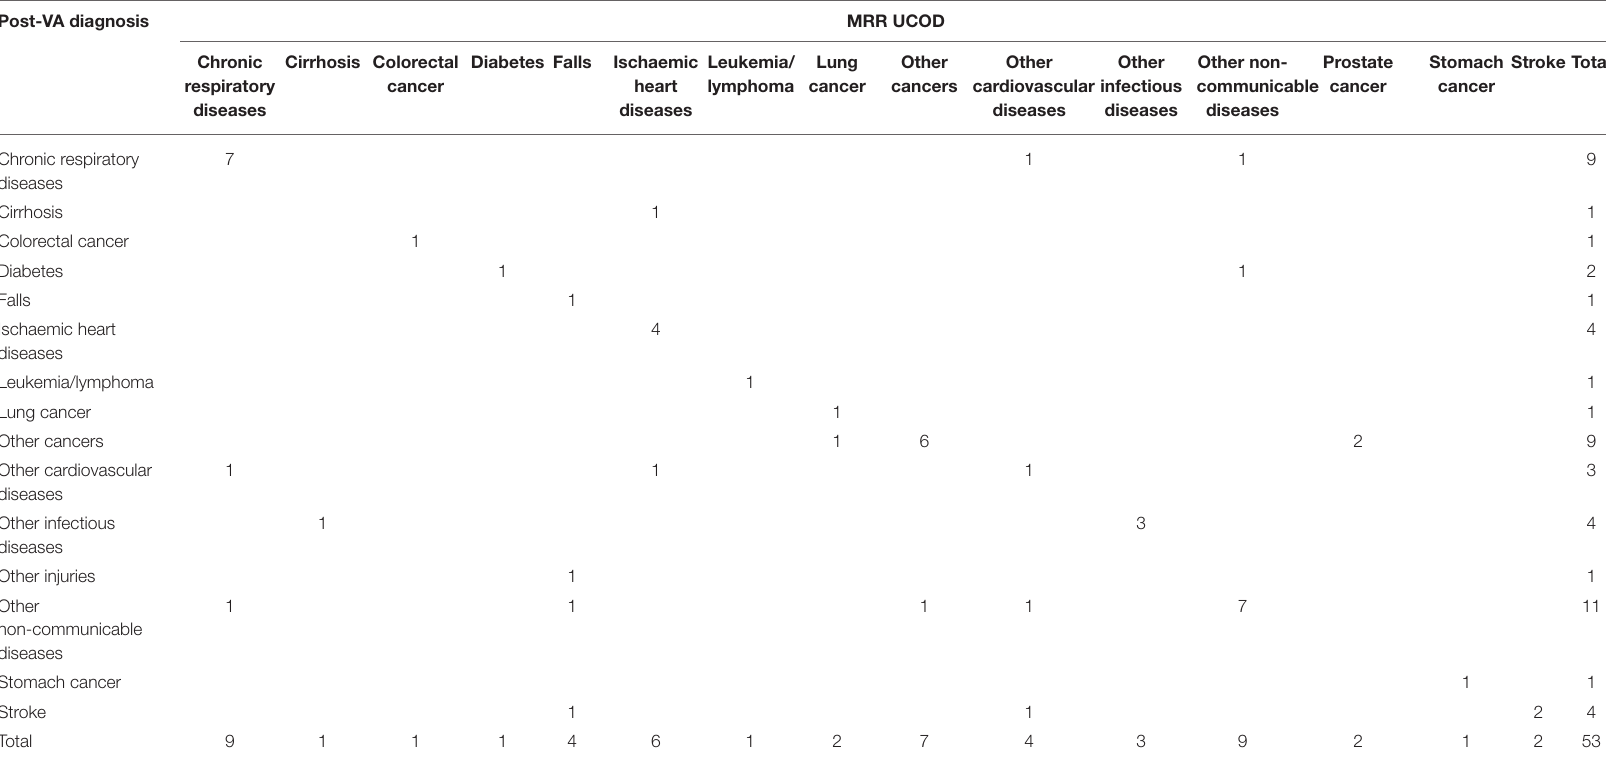
TABLE 7 | The concordance between post-VA diagnosis and MRR results of the 53 changed cases where SmartVA led to a change in diagnosis. Post-VA